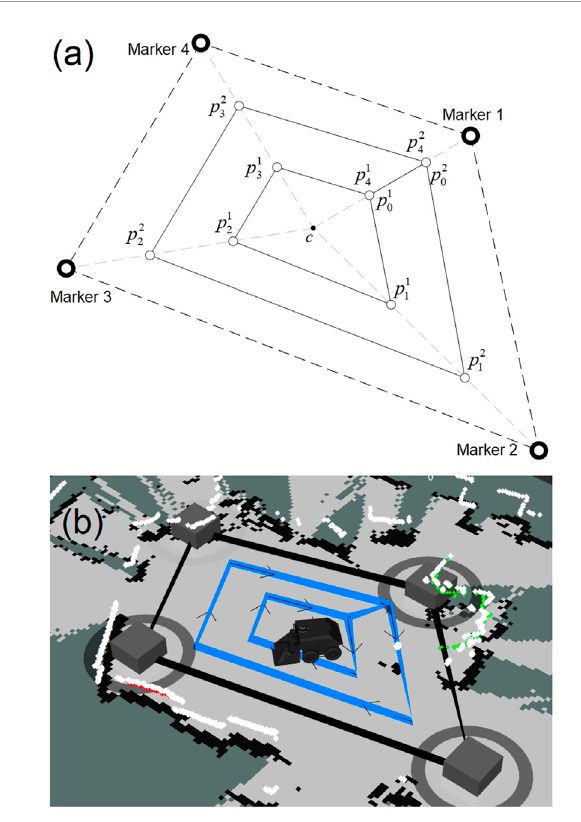
FIGURE 5 (A) : Waypoint planner schematic diagram with four markers and two loops, p j : The i th waypoint in the j th loop, c : The geometric center of i the interactive markers, (B) : Screenshot of the waypoint planner with four markers and two loops in the visualiser; the user movable markers are the grey boxes and the waypoint planner’s path is the blue line.